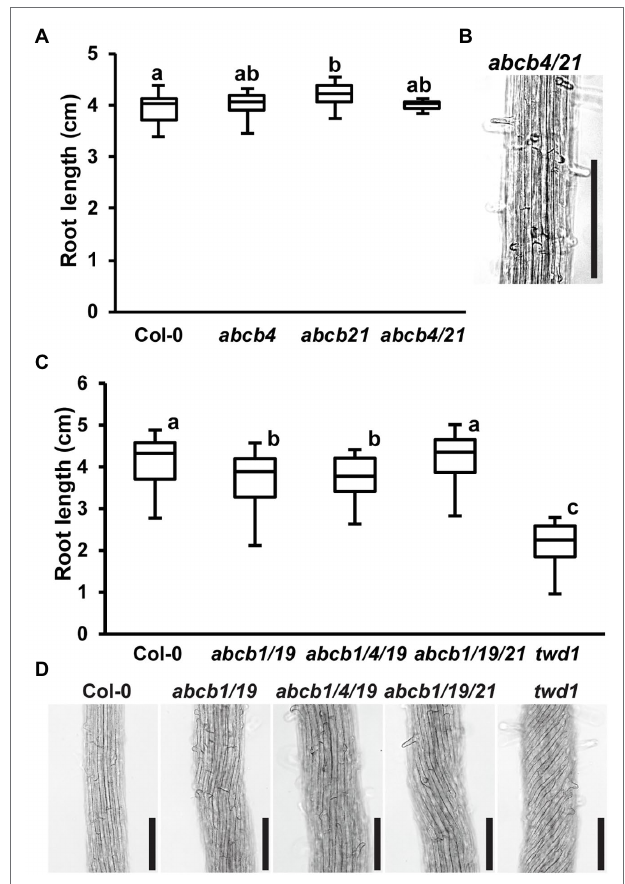
FIGURE 2 | Loss of abcb4 and abcb21 does not result in twd1 -like root phenotypes. (A) Root lengths of 7-day light-grown Col-0, abcb4 , abcb21 , and abcb4/21 seedlings. (B) Root cell files of 7-day light-grown abcb4/21 seedlings. (C) Root lengths of 7-day light-grown Col-0, abcb1/19 , abcb1/4/19 , abcb1/19/21 , and twd1 seedlings. (D) Root cell files of seedlings in (C) . Images in (B,C) were converted to black and white, and brightness and contrast were adjusted to show cell files. Lowercase letters indicate statistical difference by pairwise Student’s t -test ( p < 0.05; n = 3 replicates of 10–13). Scale bars: 200 μ